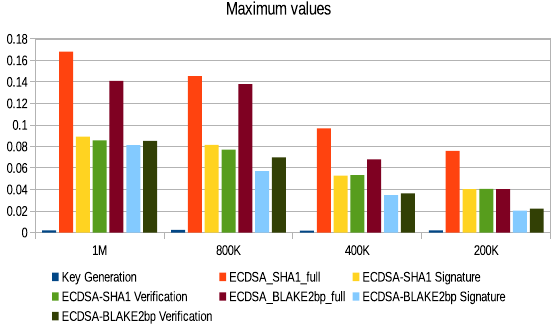
Figure 23. Maximum execution time of ECDSA algorithms with different data